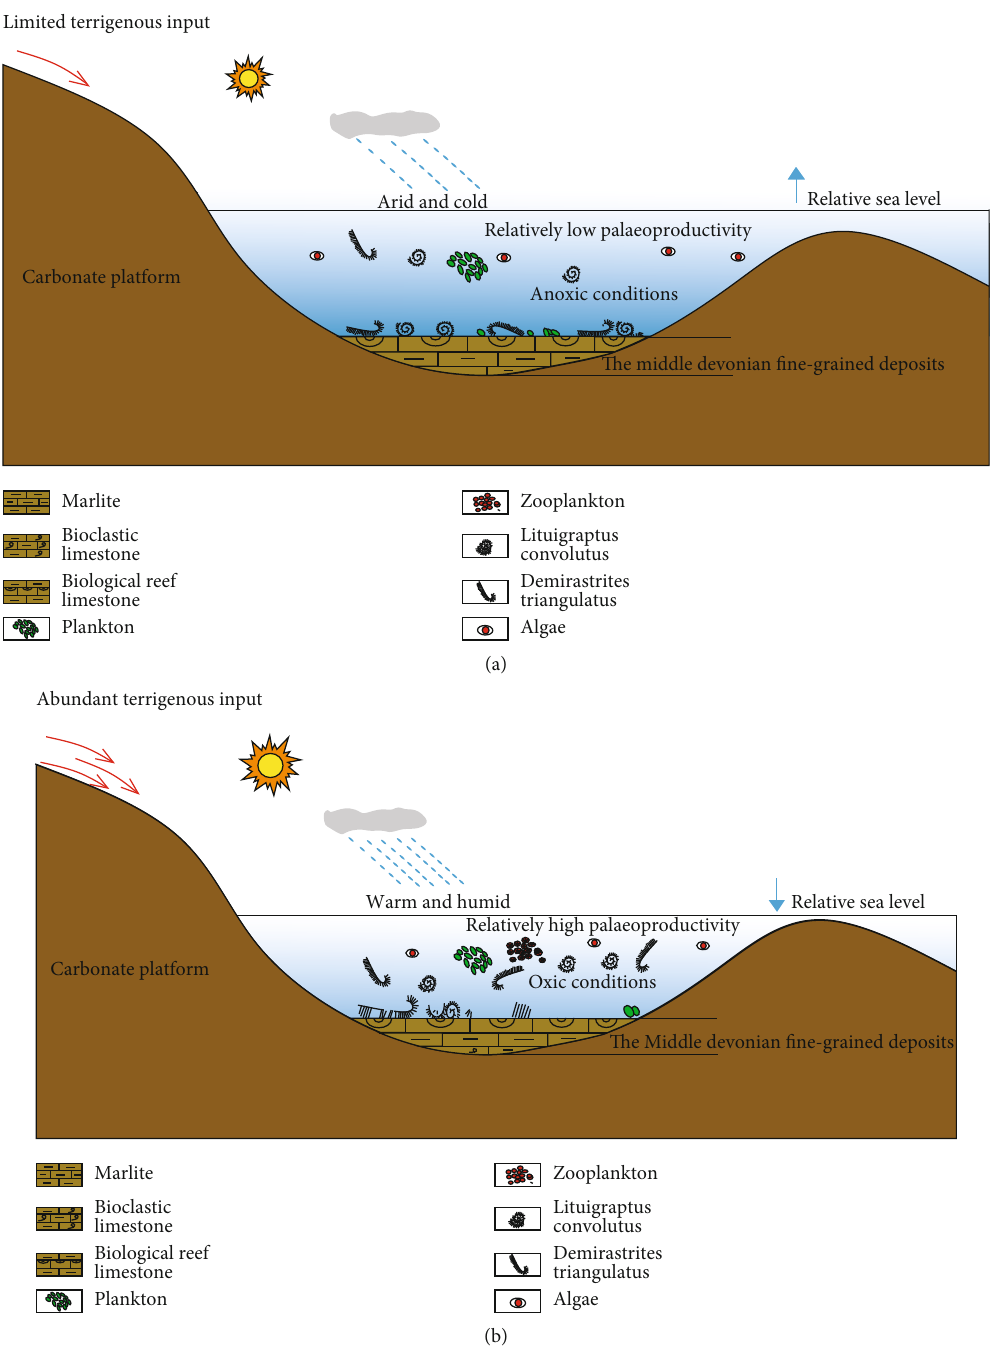
Figure 7: A conceptual model illustrating the in fl uence of the changes of relative sea level, paleoredox condition, paleoproductivity condition, and paleoclimate condition on organic matter accumulation and preservation for the Tanshanping Formation and the Dacaozi Formation. (a) The Tanshanping Formation. (b) The Dacaozi